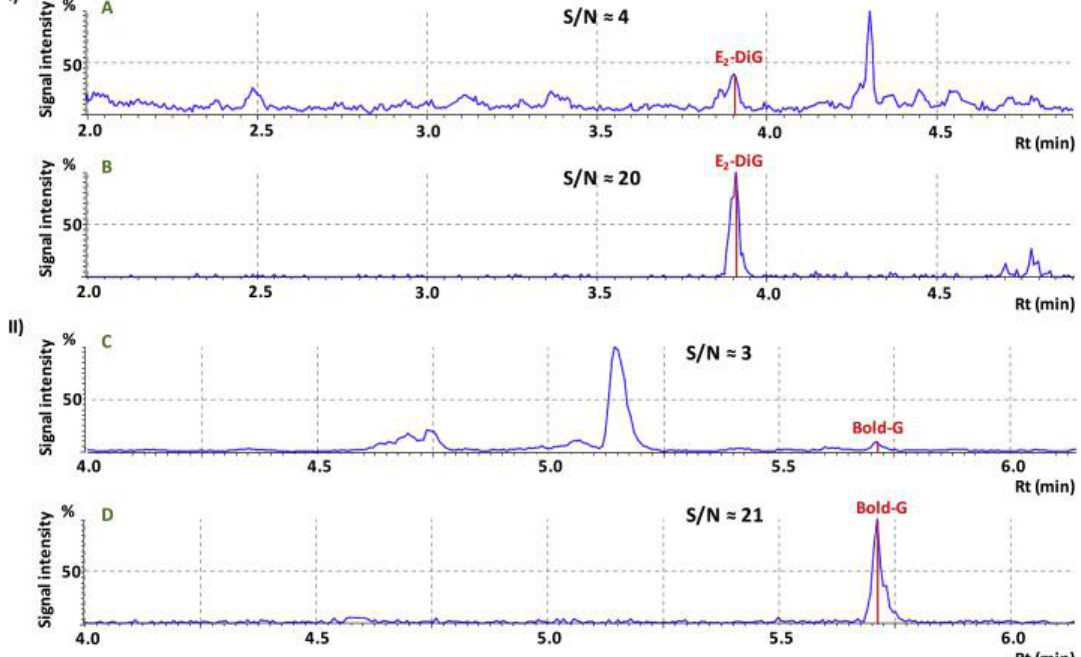
Figure 5. Extracted ion chromatograms (EICs) resulted from the analysis of: I) estradiol diglucuronide (E 2 -DiG; 2 μg mL −1 ; [M + Na] + ), and II) boldenone glucuronide (Bold-G; 0.2 μg mL −1 ; [M − H] − ) in